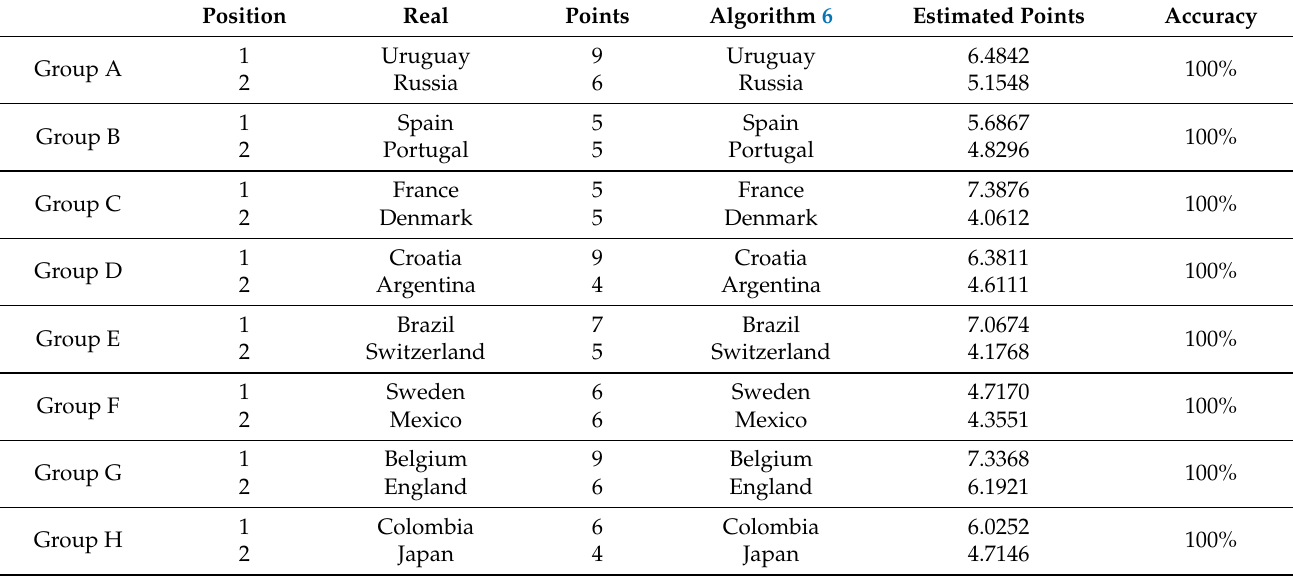
Table 14. Group winners comparison.